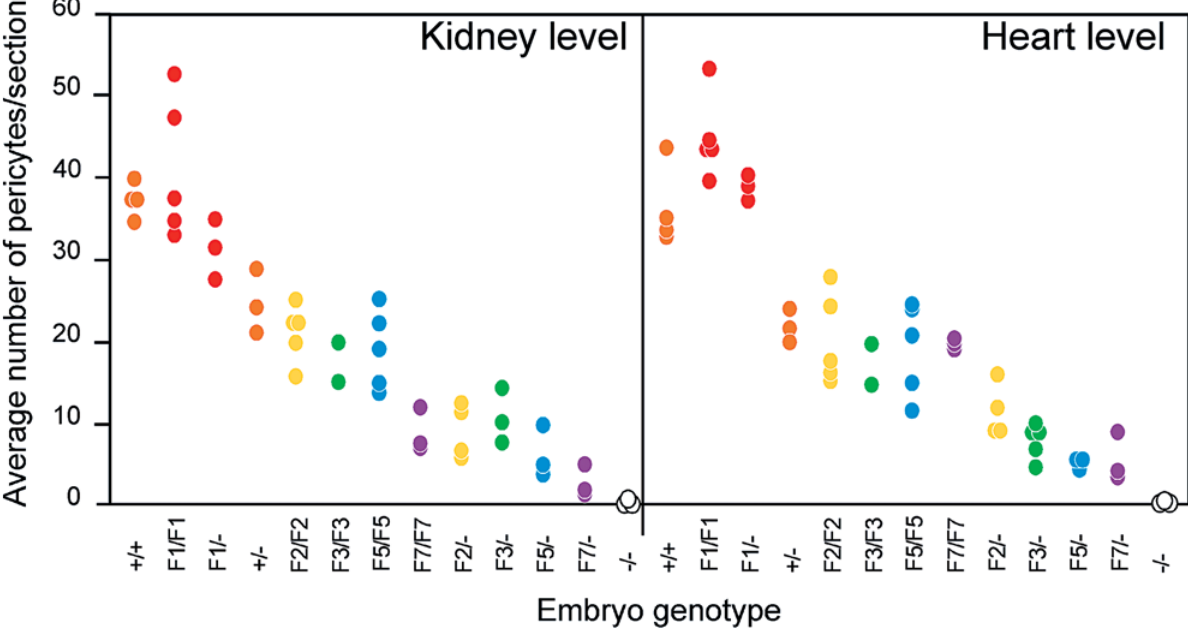
Figure 6. Quantitation of Pericytes in Nervous System b -Galactosidase-positive nuclei were counted within the neural tube. Each datapoint represents a mean of seven to ten sections from a single embryo. Data were gathered at two rostral levels in each embryo. The genotypes are ordered by the predicted strength of the signal, depending on the number of copies of the receptor being expressed and the signal transduction pathways remaining downstream of the receptor. A two- tailed Student’s t -test was performed comparing the number of spinal cord perictyes in mutants to those in wild-type, and all homozygous mutants and hemizygous mutant values were statistically different ( p , 0.005) from wild-type values. The F1/ (cid:1) was also statistically different from the PDGFR b þ / (cid:1) ( p , 0.001). DOI: 10.1371/journal.pbio.0000052.g006